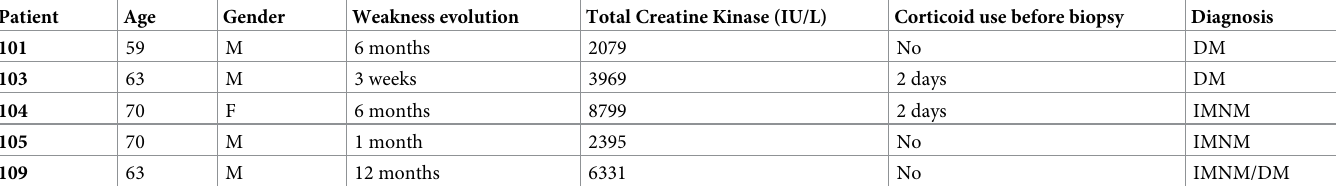
Table 1. Patient clinical